Question: According to the figure, is the described quantity increasing or decreasing?
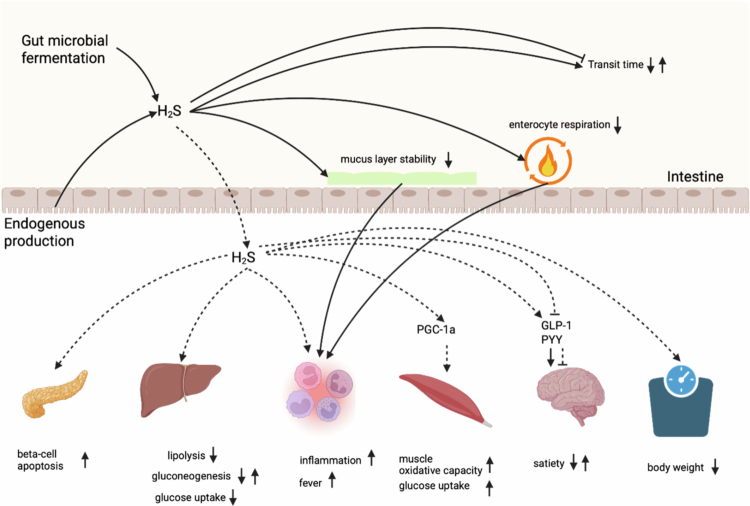
Answer: increasing